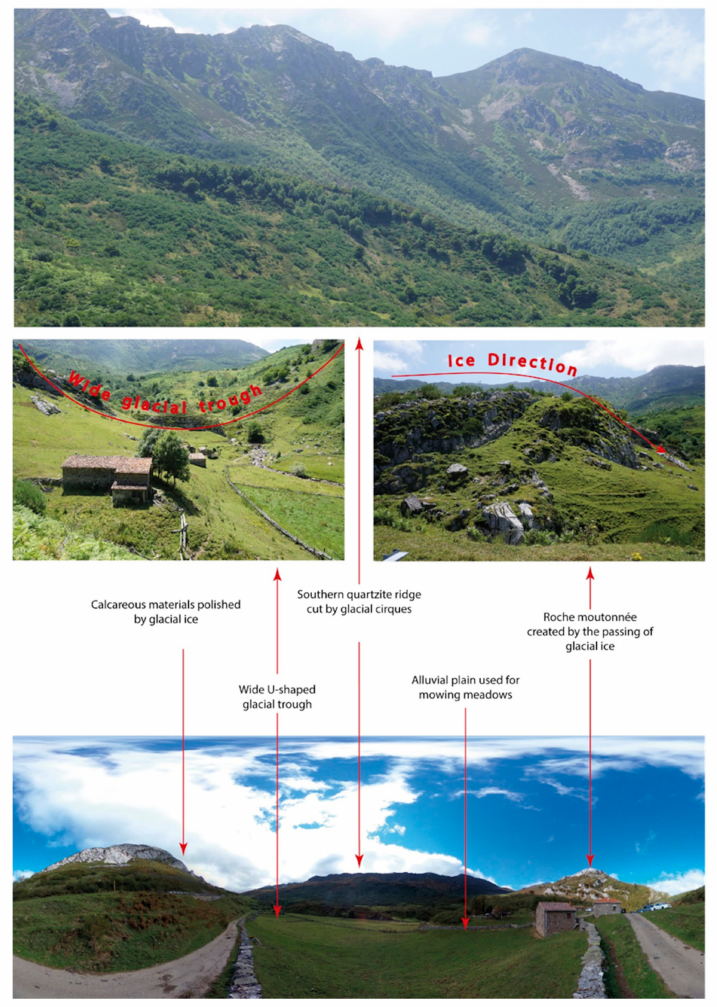
Figure 11. 360 ◦ photograph from the third POI. Photograph by the authors. Focus with camera on Figure through Onirix site or use the link